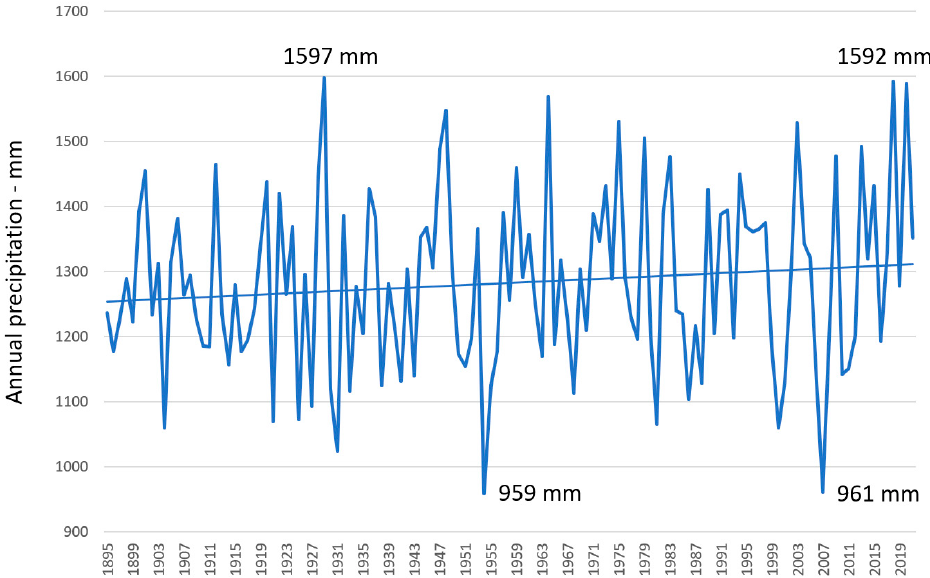
Figure 1. Early survival of pine seedlings reported for various periods in the southern United States. Adapted from [4–8]. Coastal Plain, Piedmont and Highland provinces were defined by Schultz [9].